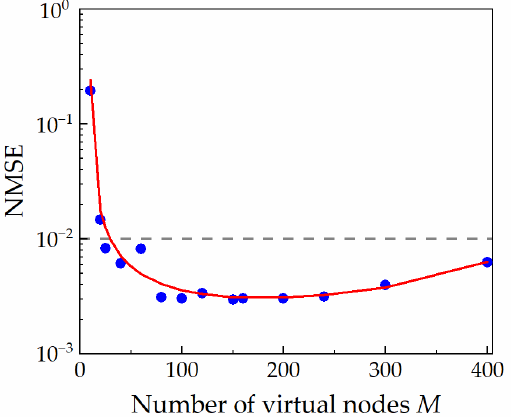
Figure 4. NMSEs as a function of the number of virtual nodes M , with I = 12 I th , κ inj = 0.4, κ f = 1%, the dashed line indicates NMSE = 0.01.